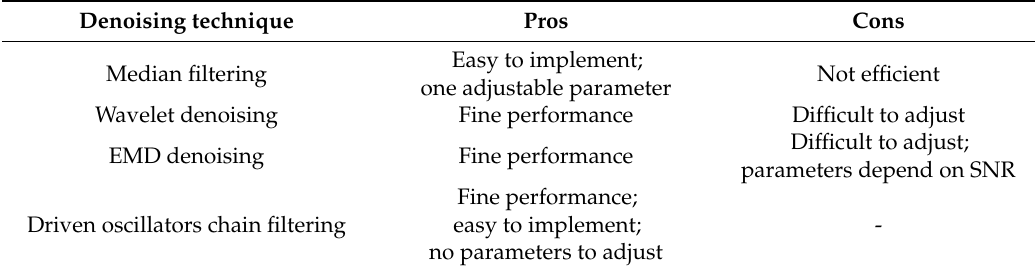
Table 1. Brief comparison of nonlinear denoising techniques for chaotic signals.